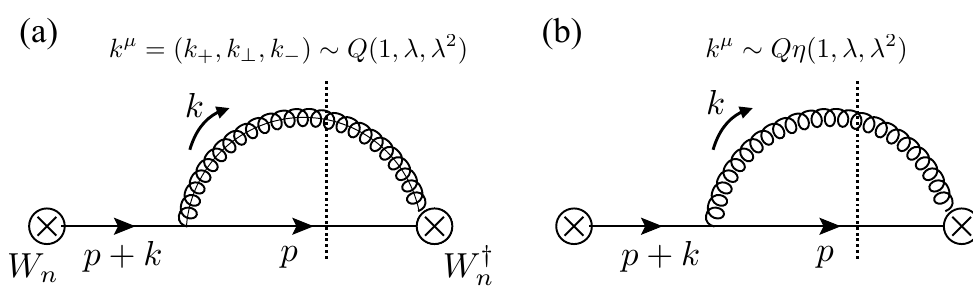
Figure 1 . (a) One sample Feynman diagram for real gluon radiation contributing to the integrated heavy quark jet function. Diagram (b) corresponds to the zero-bin contribution to the diagram (a). Dotted lines indicate unitary cuts where particles are